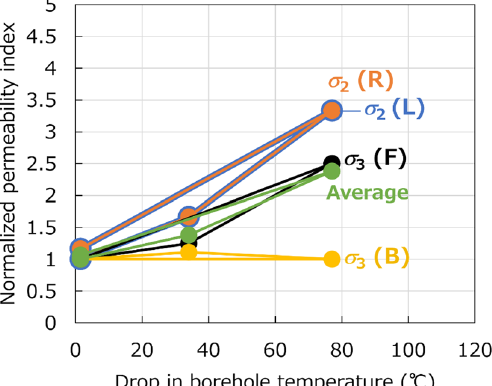
Fig. 5 Relationship between the normalized permeability index and drop in borehole temperature for each direction in Run 1. σ x (y) denotes the outlet face, y (R: right face, L: left face, F: front face, B: back face) subjected to the principal stress, σ x (x: 1, 2,